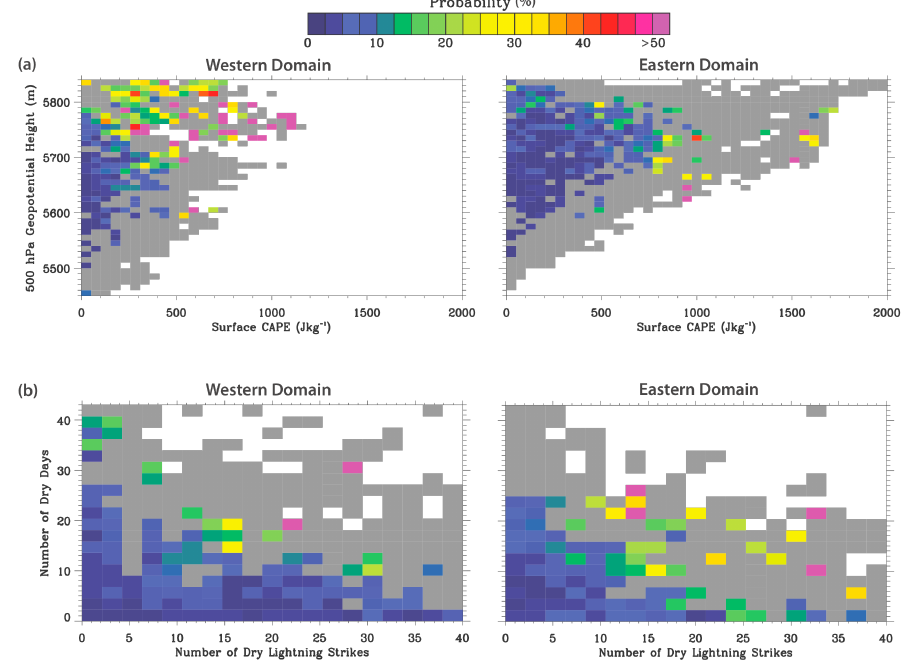
Figure 9. Fig. 9. (a) Probability of dry lightning strikes igniting a fire in a grid box based on CAPE and 500hPa geopotential heights with a holdover (lag) effect of 2 days in the western domain (left) and 3 days in the eastern domain (right). The observed CAPE and height values associated with fire ignition for 2000–2006 are shaded in color based on probability, observed values not associated with fire ignition are shaded in grey, and white areas do not contain observed data. (b) Same criteria as (a) but for but for the probability of a fire ignition in a grid box based on the number of dry lightning strikes and the number of consecutive dry